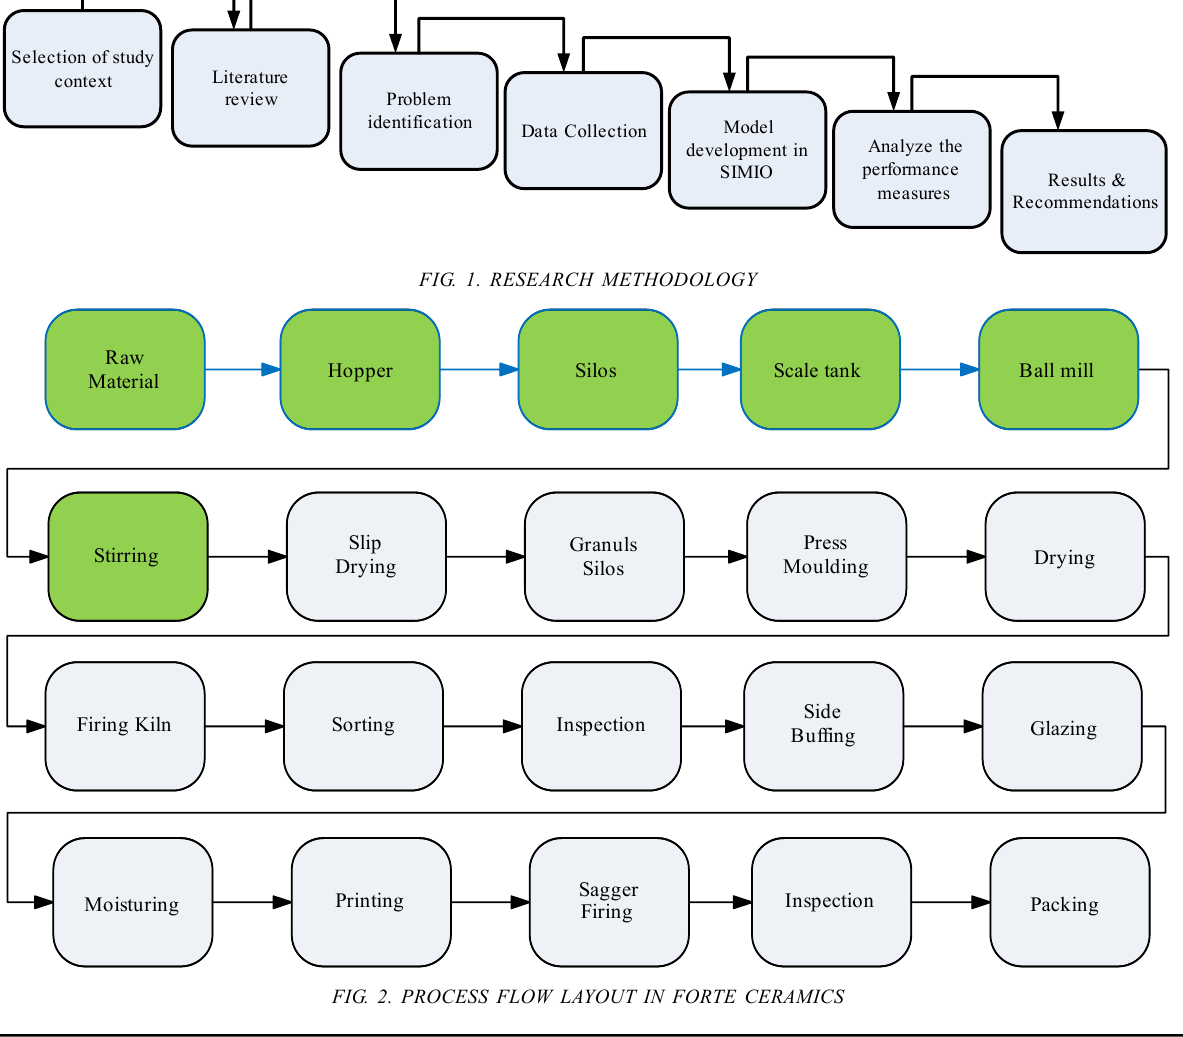
FIG. 2. PROCESS FLOW LAYOUT IN FORTE